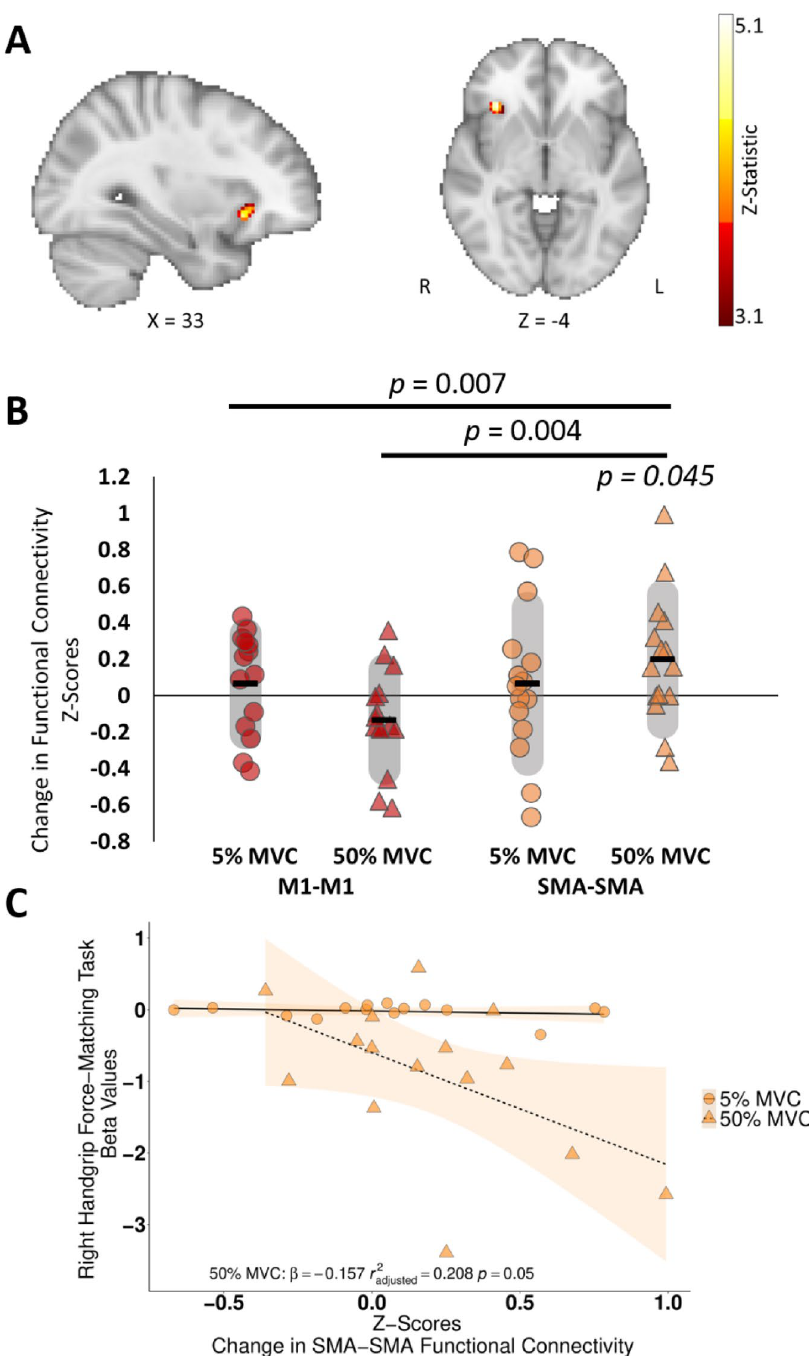
Figure 3. Functional connectivity analyses for ( A ) Seed-based functional connectivity analysis between the right ipsilateral primary motor cortex (seed) and the rest of the brain in the 50% MVC condition, data is a Z-statistic threshold map in standard space. Z-threshold = 3.1. Figure is in radiological view (left on right, right on left). ( B ) Change in interhemispheric functional connectivity between contralateral and ipsilateral primary motor cortices (M1–M1; red data points), and the contralateral and ipsilateral supplementary motor areas (SMA–SMA; orange data points) for 5% MVC (circles) and 50% MVC (triangles). Back horizonal bar represents the mean change. Grey shaded area represents the standard deviation. p = 0.007: significant condition × ROI × time interaction, p = 0.004: significant ROI × time interaction for 50% MVC condition, p = 0.045: significant paired-sample t-test for SMA–SMA connectivity, and ( C ) Scatter plot correlation between X-axis: The change in interhemispheric functional connectivity z-scores between the contralateral left and ipsilateral right supplementary motor areas (SMA-SMA) and Y-axis: beta values representing the decline in motor performance over time (negative slope = performance decline over time) (r 2 adjusted = 0.208, p = 0.050, β = − 0.157). Figure 3A was made in MRIcoGL 61